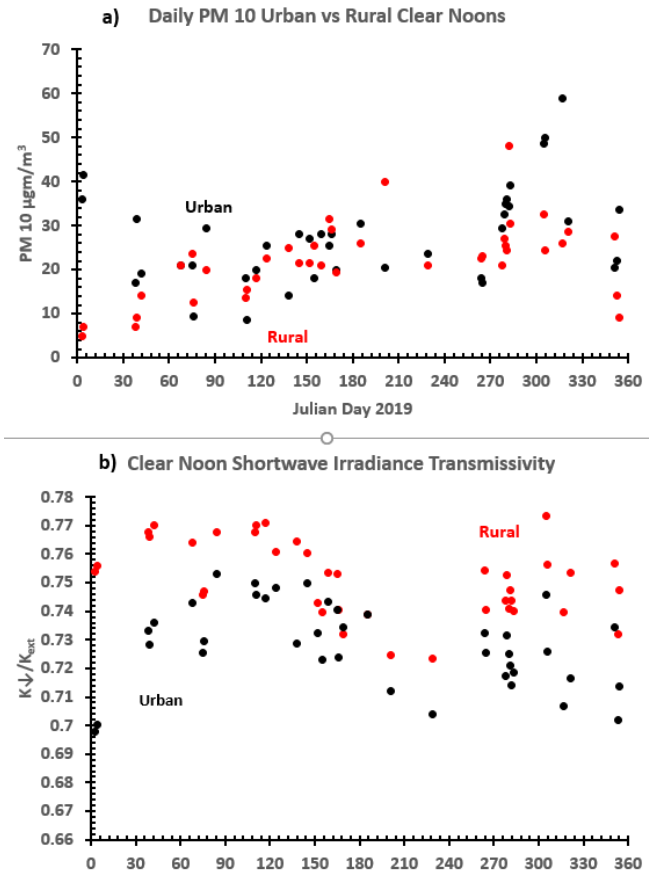
Figure 5. ( a ) Transmissivity T (K ↓ /K etr ) for urban site Encanto (black dots) vs. rural site Maricopa (red dots), ( b ) Urban vs. rural daily PM10 values. Urban (black dots) is mean of West Phoenix and Durango Complex; rural (red dots) is mean of Alamo Lake and Sacaton. Since data were for selected separate days over time, no curves were fit to the data.